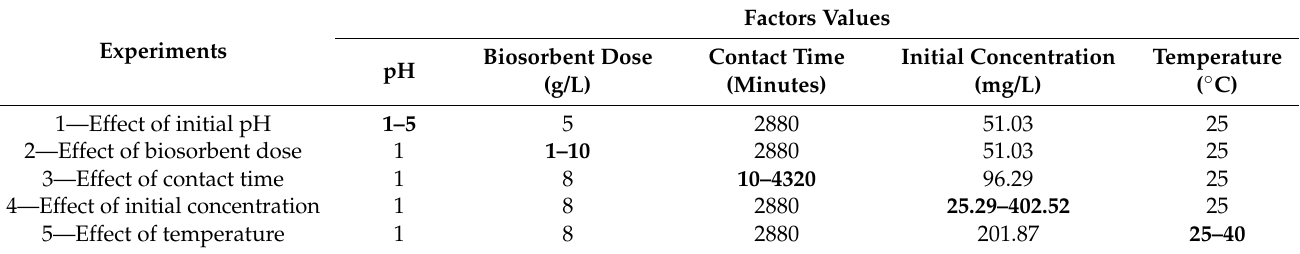
Table 1. Values of influencing factors used in experimental studies for Cr 6+ biosorption.